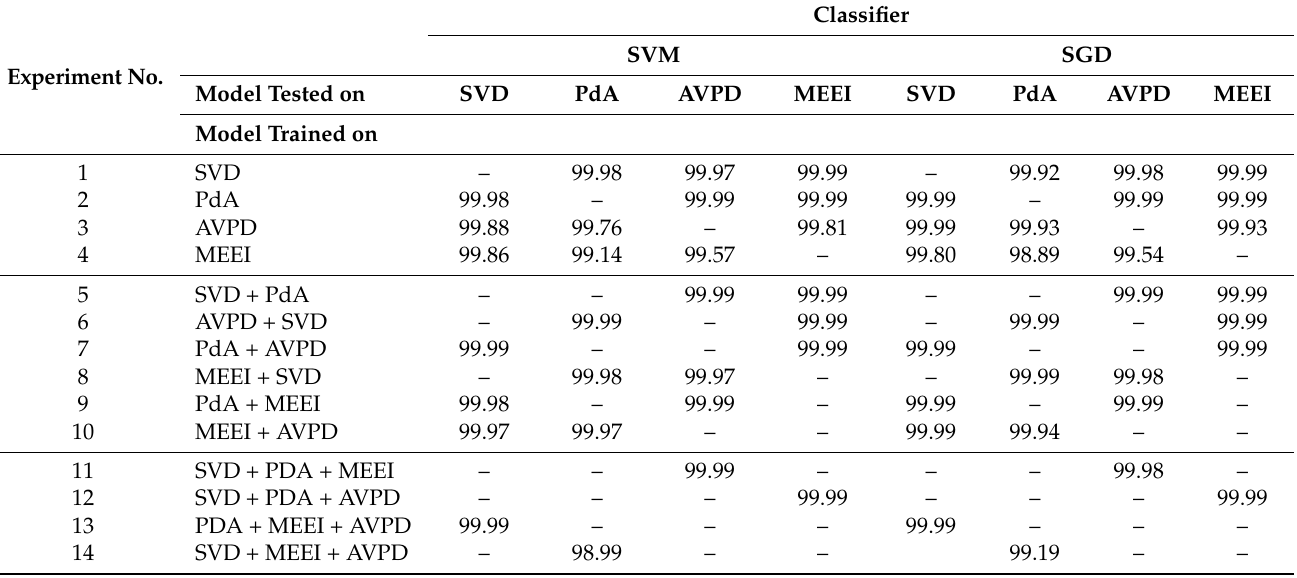
Table 8. Identification rate (%) for cross-dataset experiments with SVM and